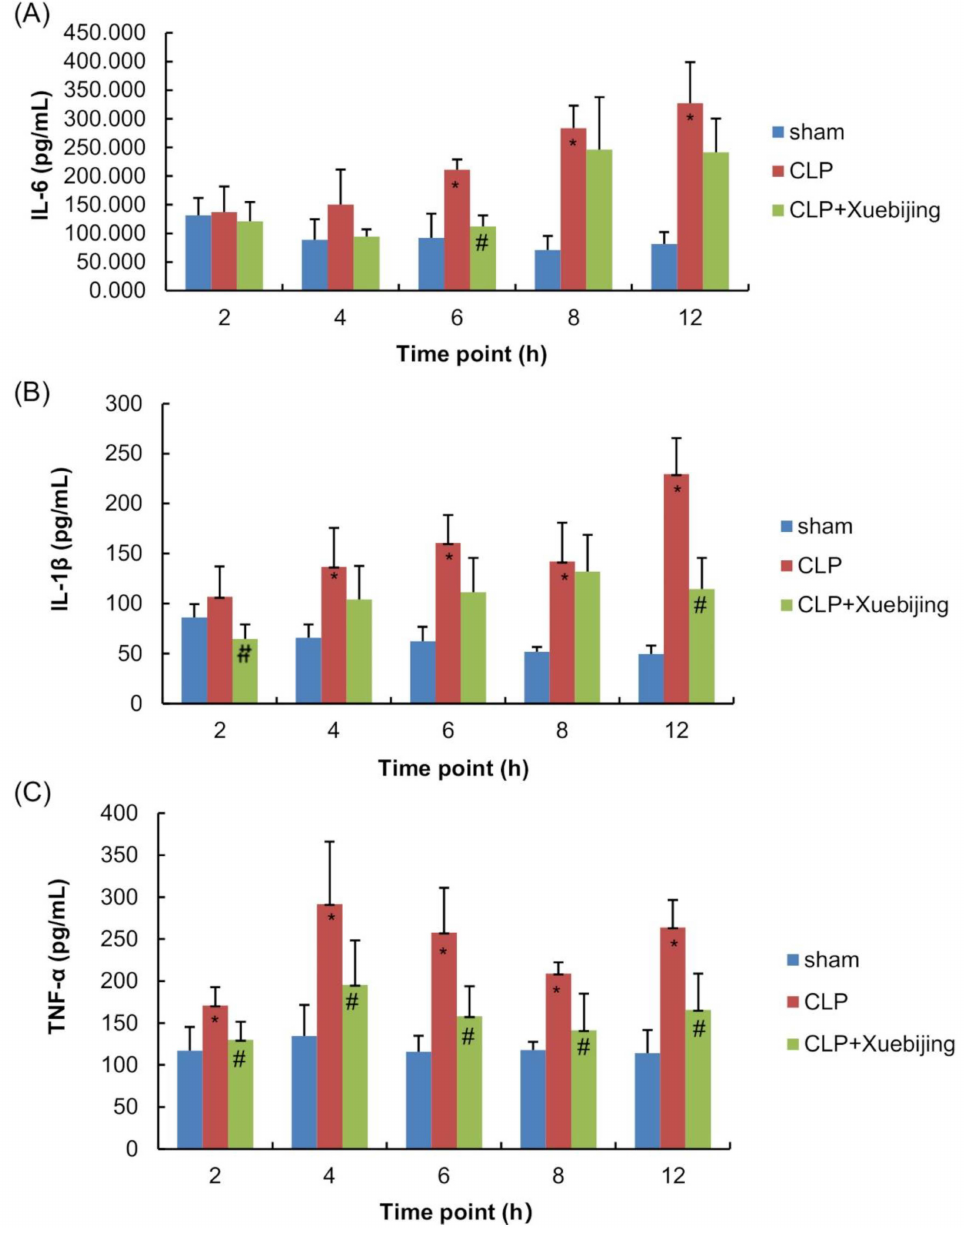
Figure 3. Xuebijing administration reduced circulating proinflammatory cytokine levels in CLP rats. Blood samples were collected at 2, 4, 6, 8, and 12 h after surgery from each subgroup. ELISA was performed to measure the plasma levels of interleukin 6 ( A ), interleukin 1 β ( B ), and TNF- α ( C ) in rats. Data are expressed as the mean ± SD. * p < 0.05 vs. sham group, # p < 0.05 vs. CLP group; n = 5. CLP, cecal ligation and puncture; TNF- α , tumor necrosis factor α